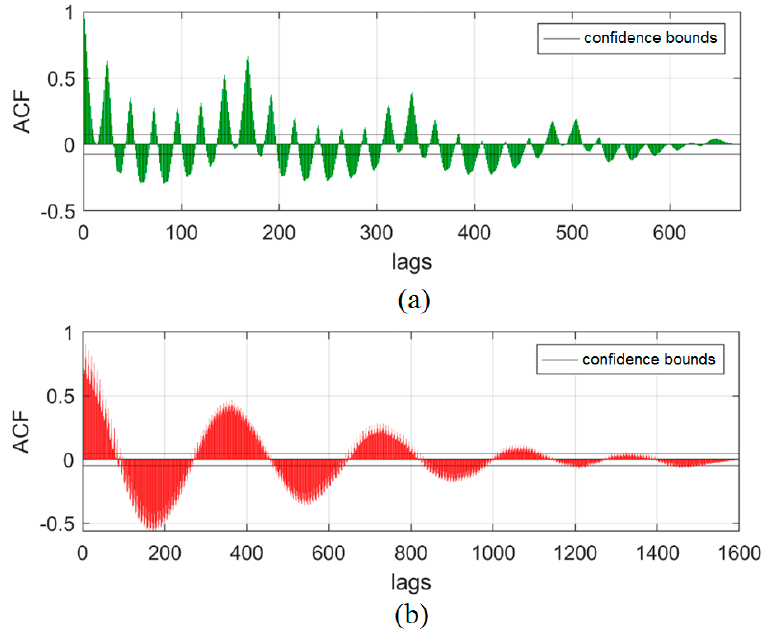
Figure 2. Autocorrelation functions (ACF) bar plot with the confidence bounds for ( a ) the Brazilian and ( b ) the Polish